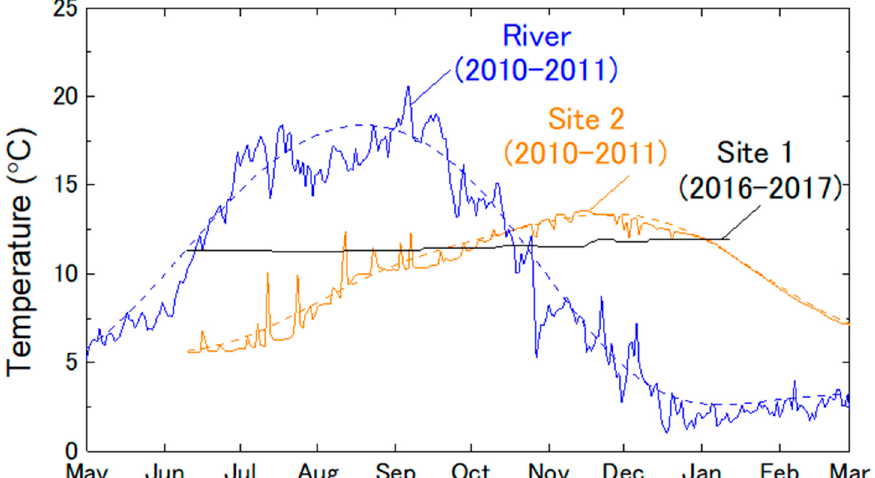
Figure 4. Variations in the temperature observations of groundwater at Site 1 and Site 2, and of surface water in the Toyohira River. The observation periods were between May 2010 and March 2011 for Site 2 and the river, and between June 2016 and February 2017 for Site 1.